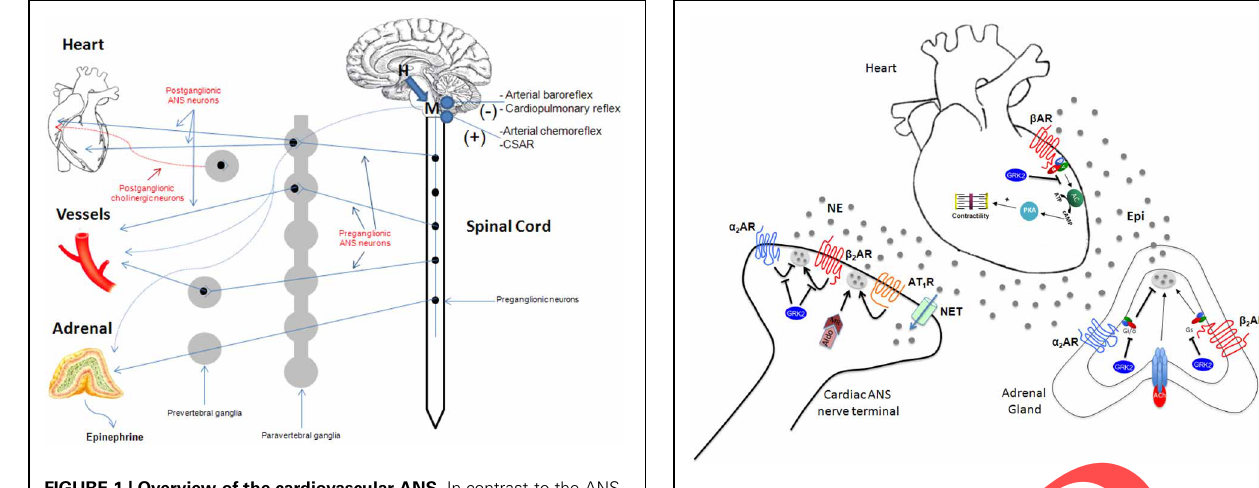
FIGURE 2 | ANS-dependent regulation of cardiac function. See text for details. G i / o , inhibitory or other G protein; G s , stimulatory G protein; Ach, Acetylcholine; NET, NE transporter; Aldo, Aldosterone; MR, Mineralocorticoid